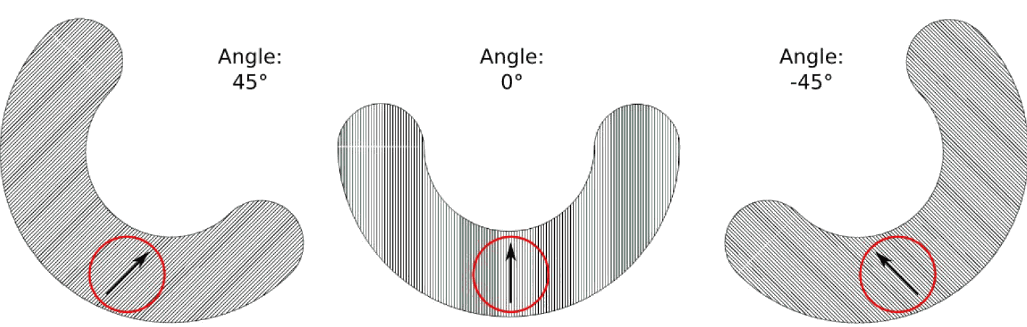
Figure 6. Linearly polarising sheet filter cut-out for use in a rotation mount. The optical axis of the filtered light beam is in the centre of the red circle. Reproduced with permission from Kölbl